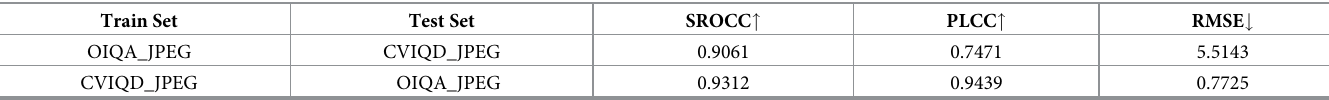
Table 5. Performance comparison of MRAPC method with different residual